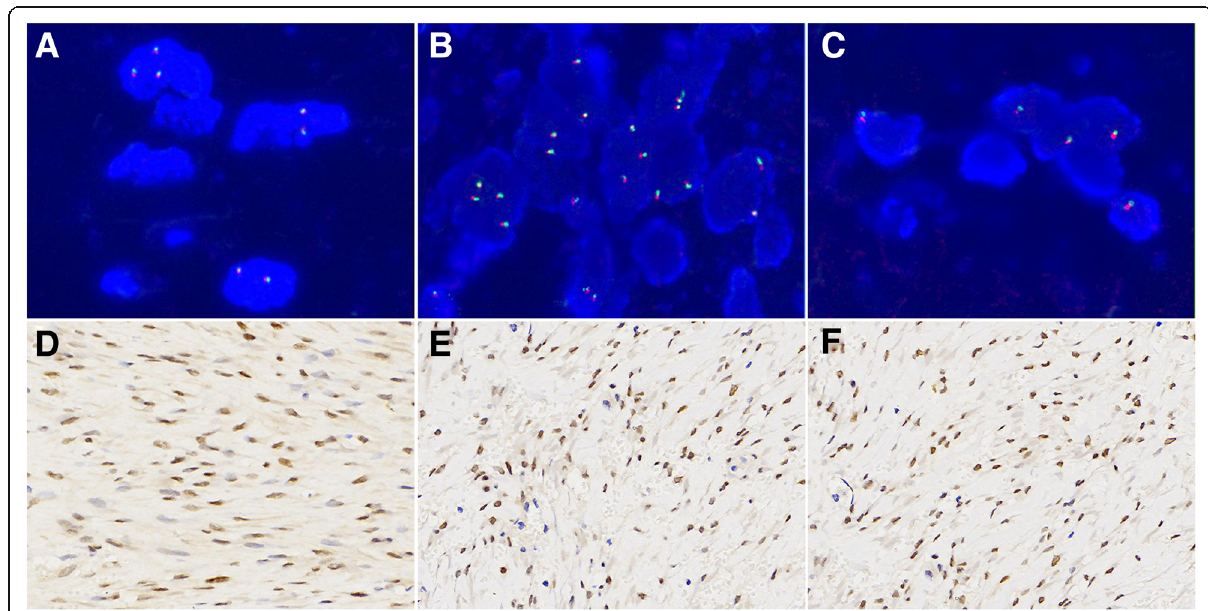
Fig. 6 Representative images of TFE3 FISH staining. A TFE3 break-apart probe assay allowed for the visualization of normal fused hybridization signals ( a , b and c , 1000×). In total, 3 DTF cases with strong positive TFE3 IHC staining were selected for this assay, and the results showed limited evidence of Xp11.2 rearrangement ( e , f and g ,